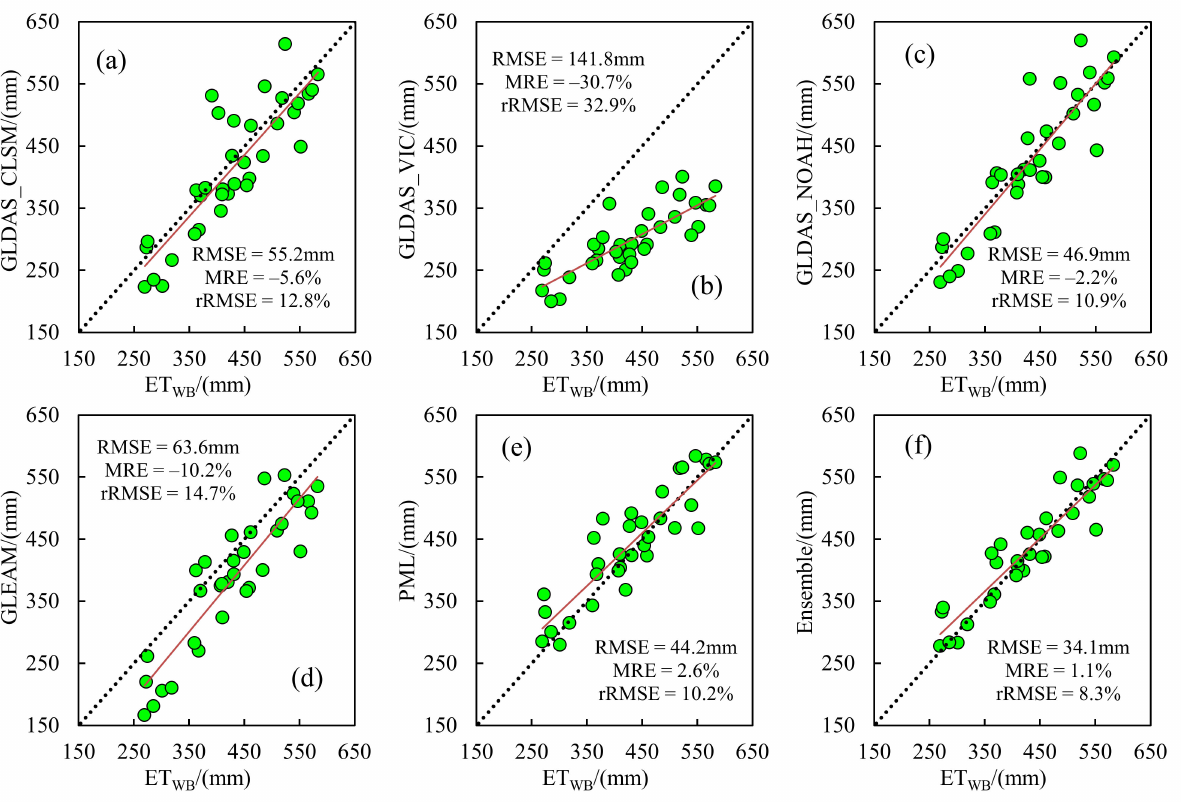
Figure 4. Accuracy assessment of the five global ET products and the ensemble ET: ( a ) GLDAS_CLSM, ( b ) GLDAS_VIC, ( c ) GLDAS_NOAH, ( d ) GLEAM_v3.3, ( e ) PML_V2, and ( f ) ensemble ET. The point represents regional ET in the each subregion at each year.